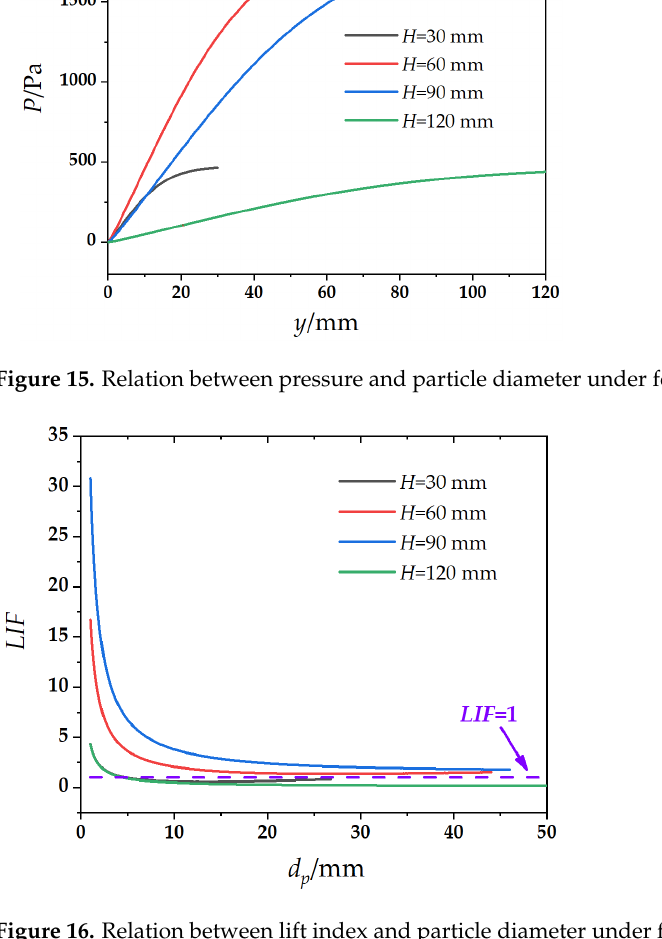
Figure 14. Relation between velocity and particle diameter under four different H / d p .